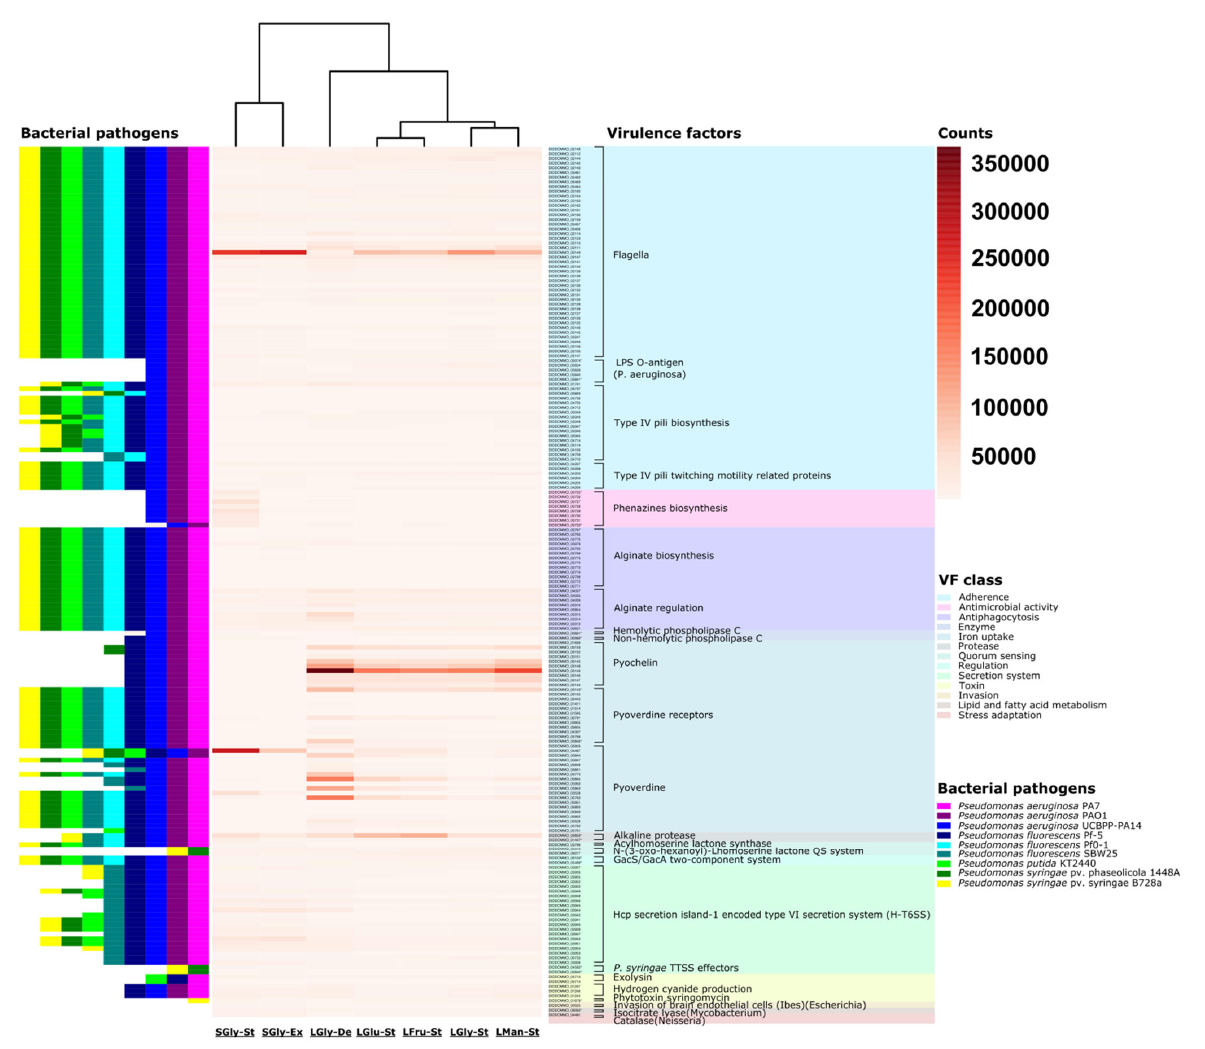
Figure 9. Heat map for predicted and expressed virulence genes in Pseudomonas sp., strain L5B5. Prediction of genes involved in virulence factors ( right ), and relation of bacterial pathogens ( left ) which own the same factors, according to the VFDB database.